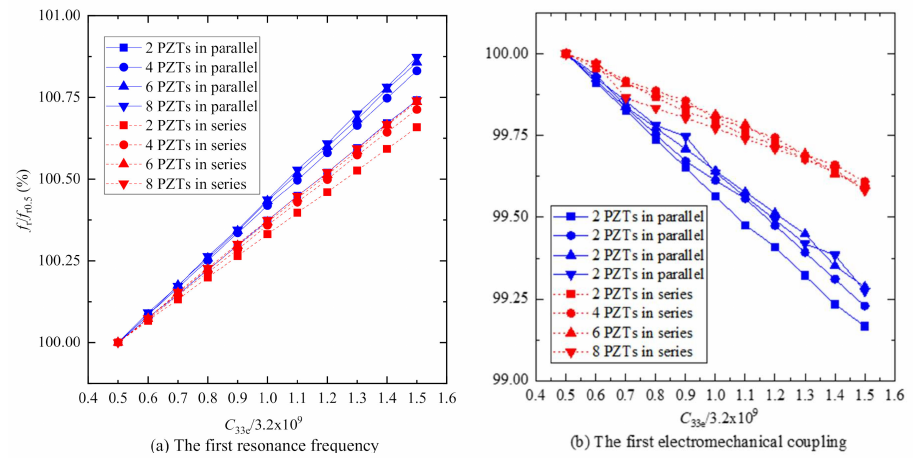
Figure 8. The first resonance frequency f r and electromechanical factor k of PiSSAs versus the Young’s modulus of the epoxy C 33e ( f r0.5 and k 0.5 are the first resonance frequency and electromechanical factor when the Young’s modulus is 0.5 times of 3.2 GPa): ( a ) the first resonance frequency; and ( b ) the first electromechanical coupling factor.